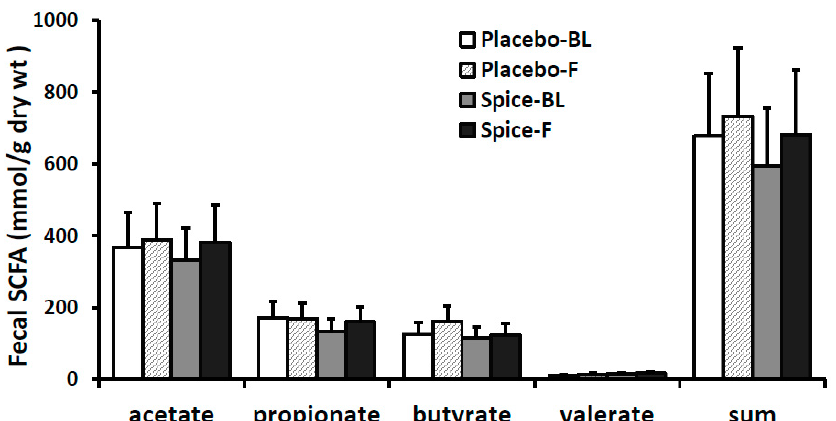
Figure 5. Fecal short-chain fatty acid production in subjects supplemented with placebo ( n = 15) or mixed spices ( n = 14) at baseline and after 2 week intervention. Data are means ± standard errors (SE). BL, baseline; F, follow up. Table 3. Correlation between percent relative abundance of bacteria and SCFA concentration after 2 week spice intervention. Acetate Propionate Butyrate Sum R p R p R p R p Firmicutes − 0.254 0.27 − 0.391 0.04 − 0.210 0.28 − 0.290 0.13 Bacteroidetes 0.287 0.14 0.435 0.07 0.216 0.27 − 0.083 0.27